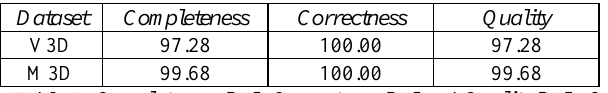
Table 5. Completeness [%], Correctness [%] and Quality [%] of all crowd jobs of the integrated cylinders of V3D and M3D